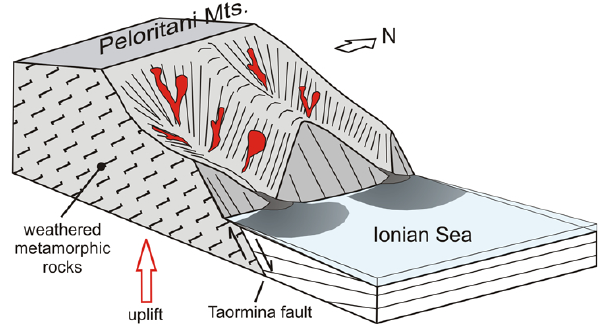
Fig. 9. Sketch summarizing the morphological, geological and tec- tonic features of the Peloritani Mts. Modified from Goldsworthy and Jackson